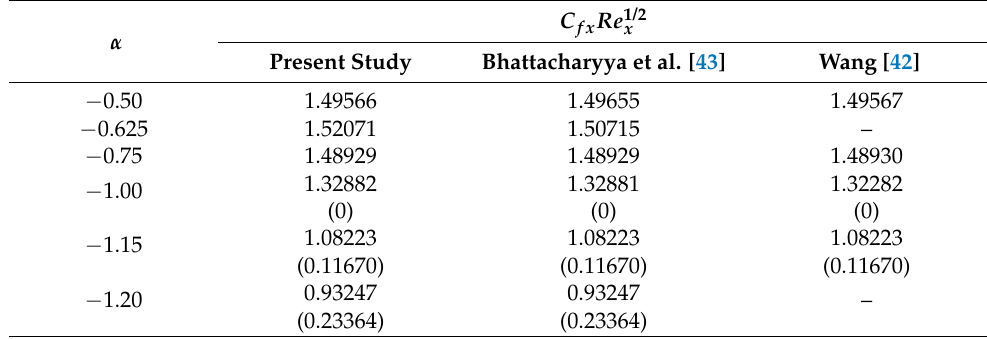
Table 3. Comparison of C fx Re 1/2 x for the present study and those by Wang [42] and Bhattacharyya et al. [43].